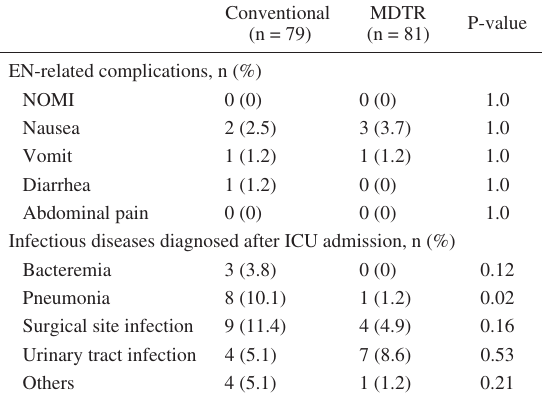
Table 4. Enteral nutrition-related complications and infec- tious diseases diagnosed after ICU